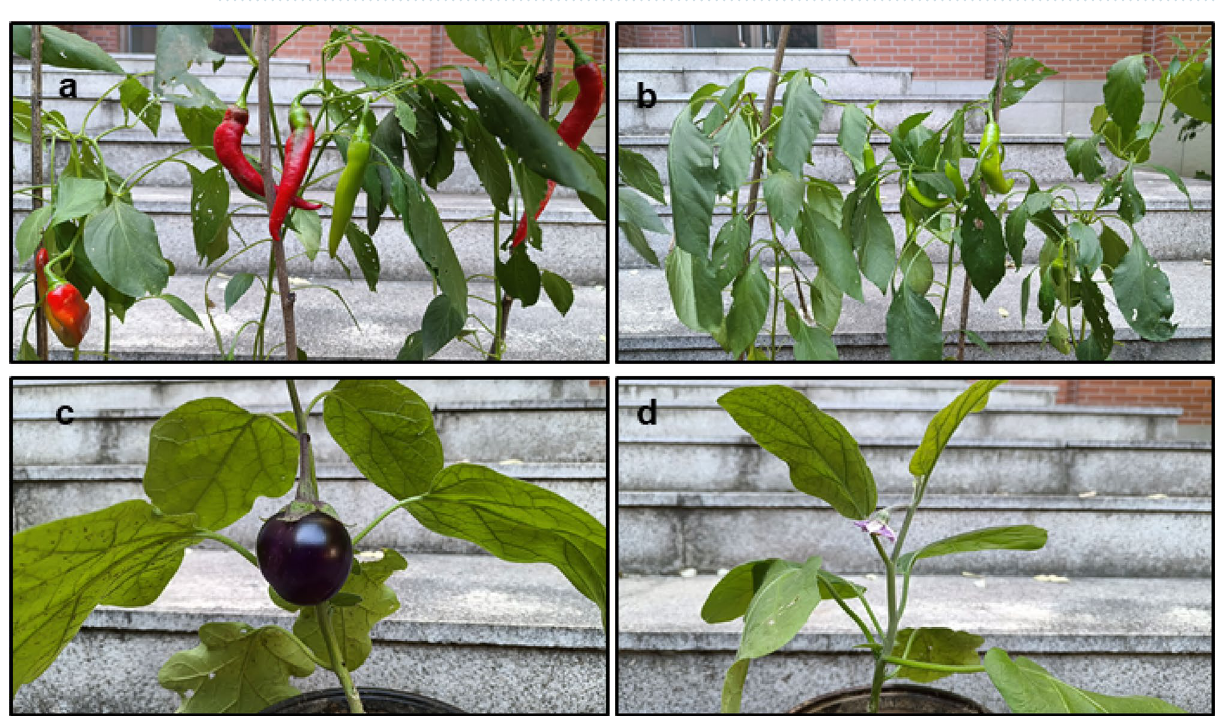
Figure 7. Daily plant growth analysis within one month of cultivation. ( a ) Tomato growth monitoring, ( b ) Chili growth analysis.